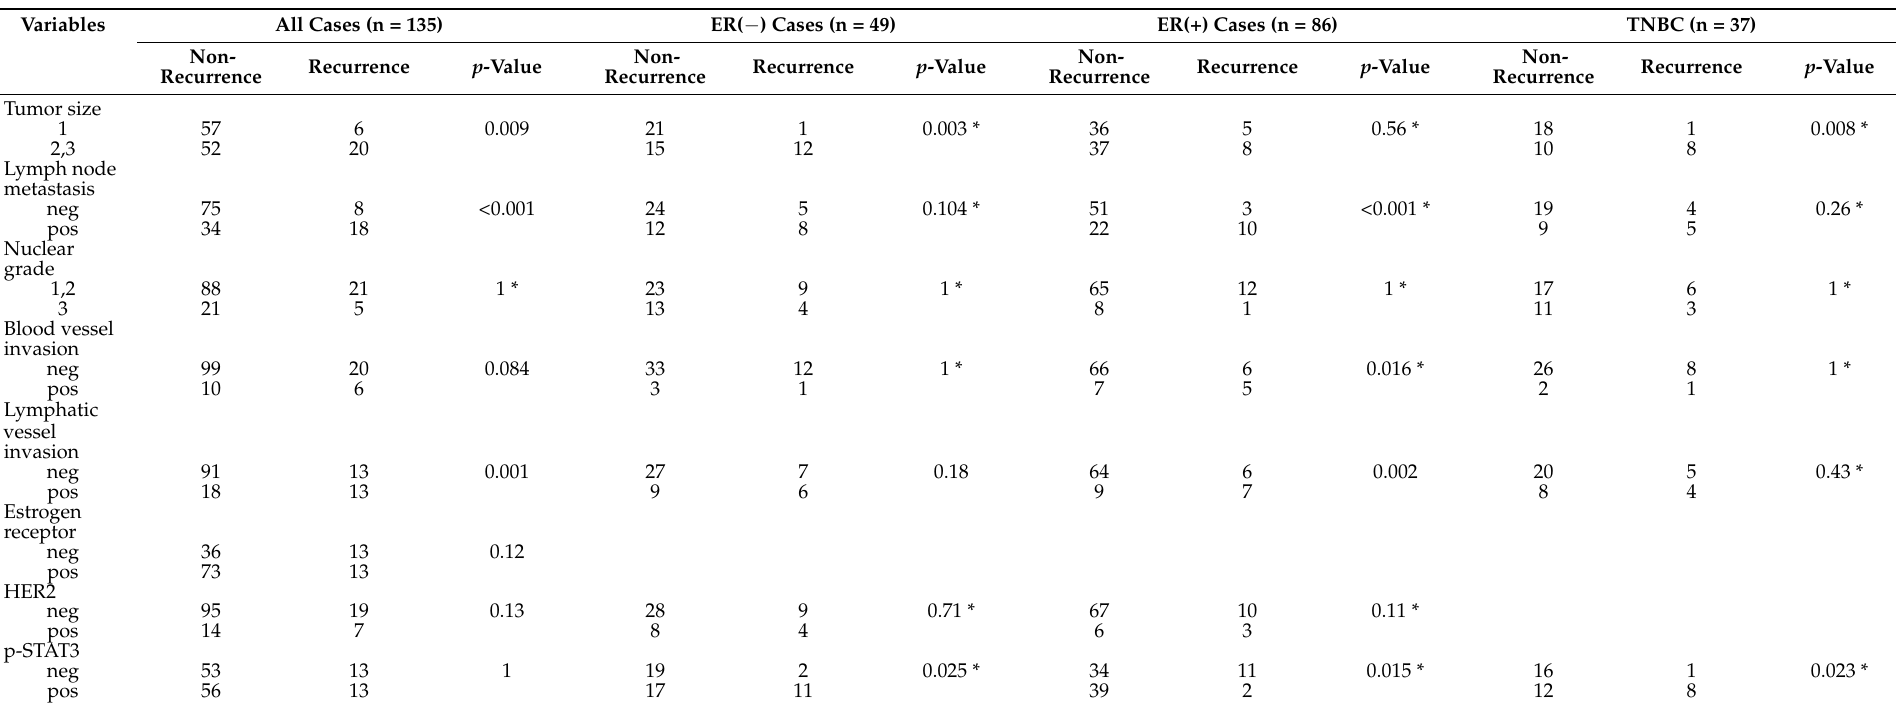
Table 2. Relationship of p-STAT3 expression and clinicopathological/biological factors to disease recurrence in all cases, ER( − ) cases, ER(+) cases and TNBC